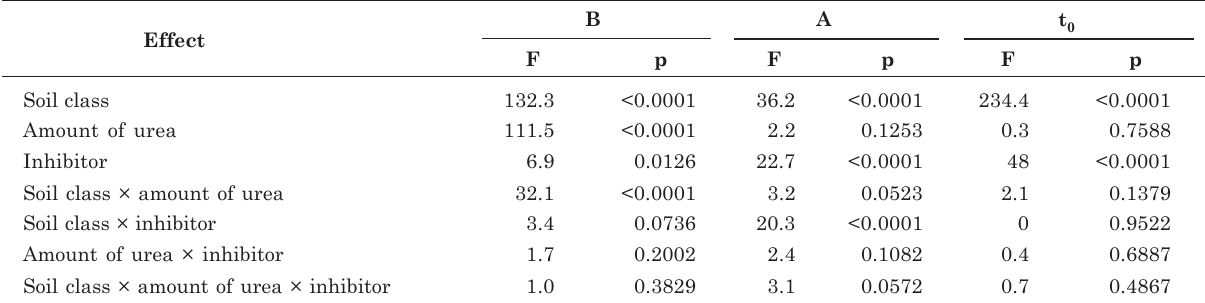
Table 6. F statistics and “p” probability of hypothesis tests by ANOVA for each model